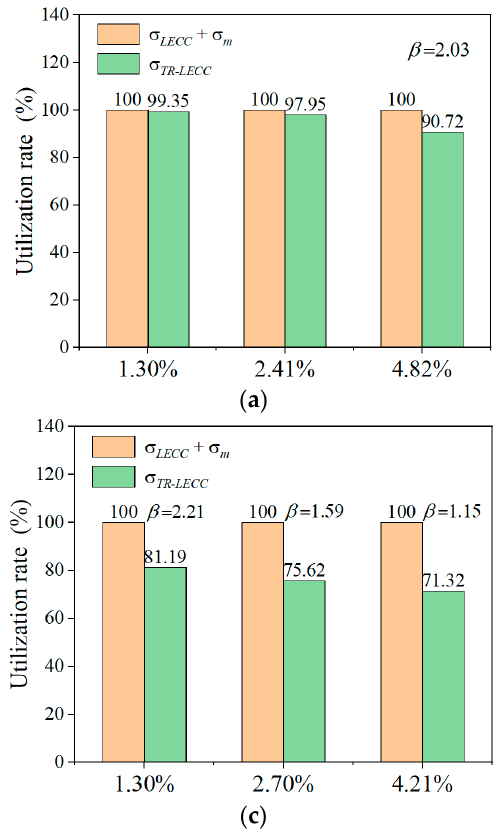
Figure 11. Material utilization of different textile types: ( a ) PP textile, ( b ) BFRP textile, and ( c ) BFRP grid.